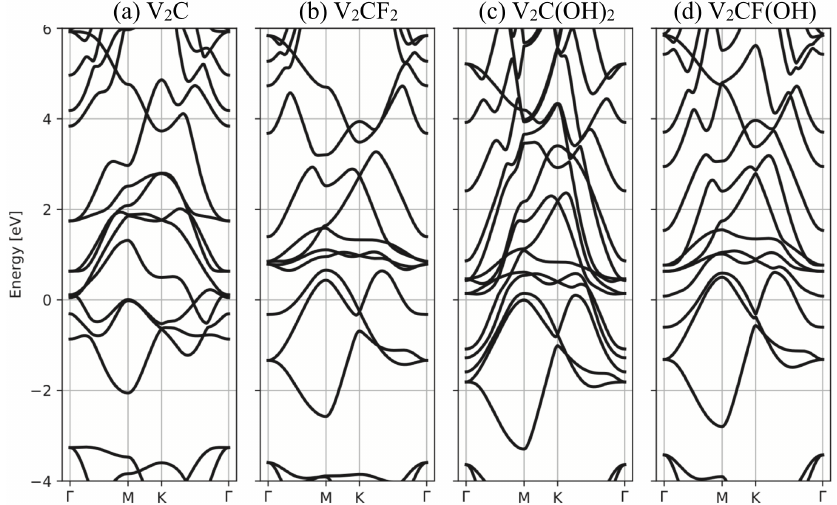
Figure 8. Electronic band structure of ( a ) pristine V 2 C, and terminated ( b ) V 2 CF 2 , ( c ) V 2 C(OH) 2 , ( d ) V 2 CF(OH). The Fermi level is fixed as the reference of zero